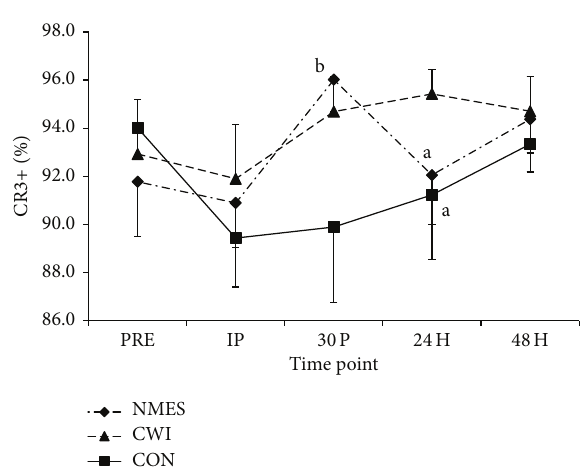
Figure 4: Proportion of CR3+/CD14+ monocytes (mean ± SE). Changes in CR3 expression before exercise (PRE), immediately after exercise (IP), and 30 minutes (30P), 24 hours (24H), and 48 hours (48H) after exercise in neuromuscular electrical stimulation (NMES), cold water immersion (CWI), and control (CON) groups. (a) A “likely” lower value than CWI at the specified time point. (b) A “likely” greater change from IP than CON at the specified time